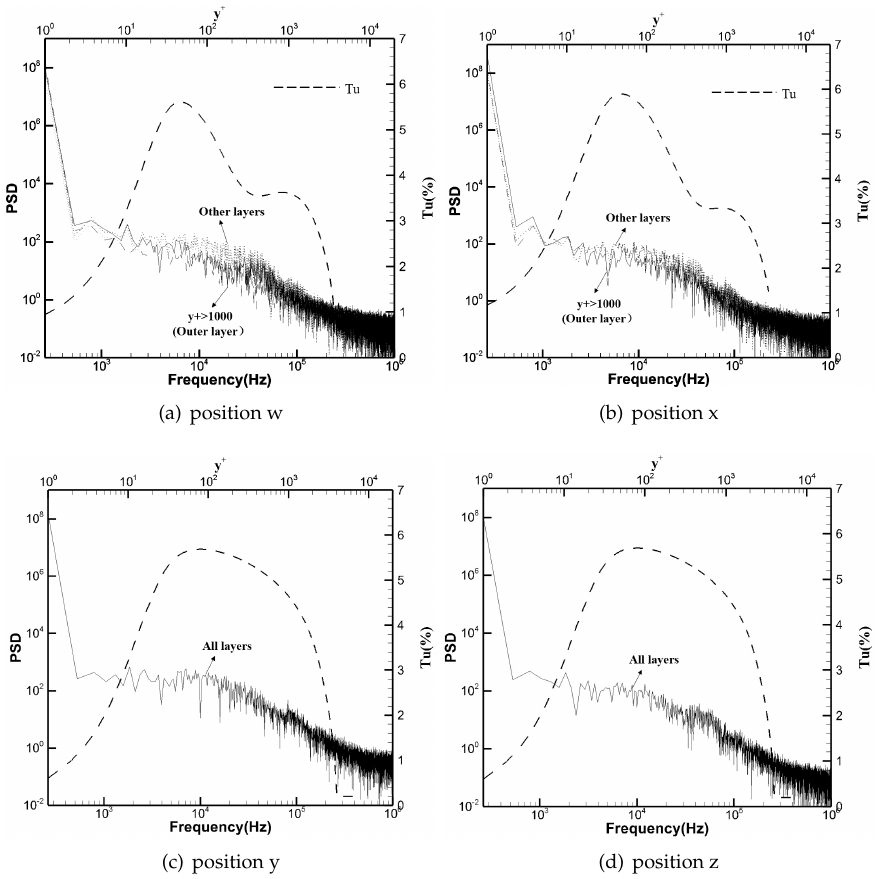
Figure 12. PSD and turbulent intensity at positions